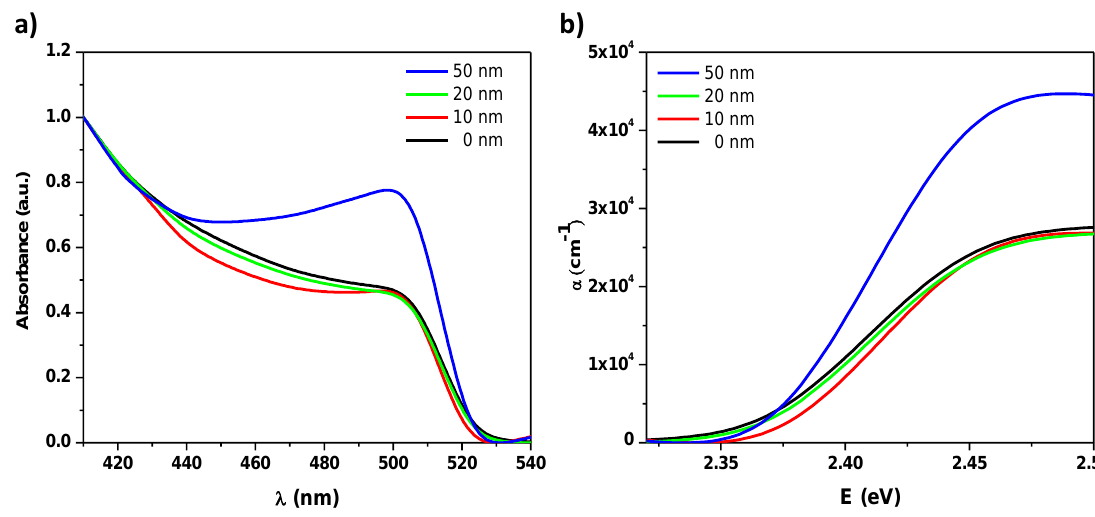
Figure 3. ( a ) Absorbance spectra vs. wavelength and ( b ) absorption coefficient vs. photon energy of the pure PQDs CsPbBr 3 and CsPbBr 3 PQDs/c-TiO 2 films of 0, 10, 20, and 50 nm c-TiO 2 thickness